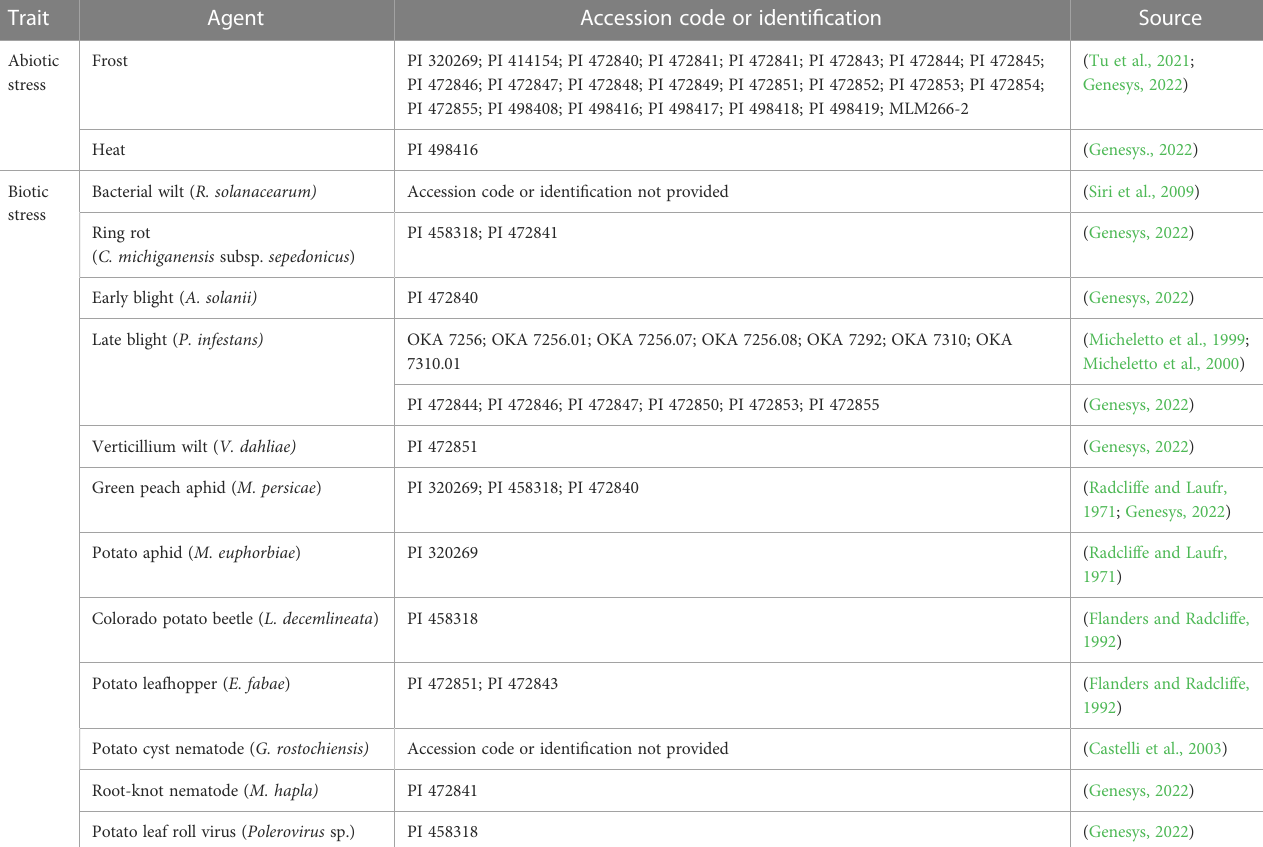
TABLE 3 Resistance against abiotic and biotic stresses reported for the wild potato Solanum malmeanum (Solanaceae). Trait Agent